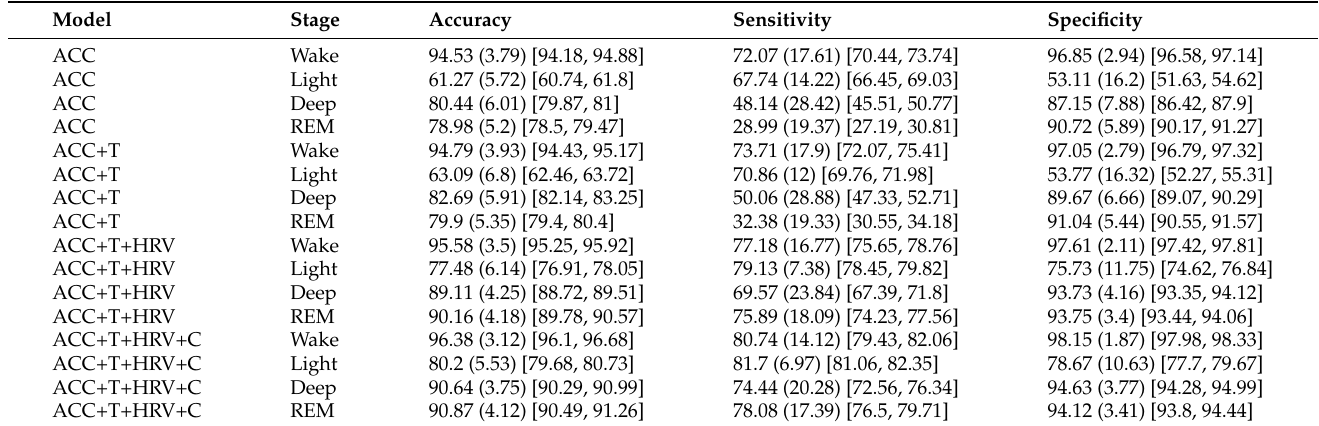
Figure 12. Epoch by epoch specificity for 4-stage classification and the four models compared in this paper. Whiskers are computed as 1.5 times the interquartile range. Table 4. Epoch by epoch sensitivity and specificity for wake, light, deep, and REM sleep and the four models compared in this